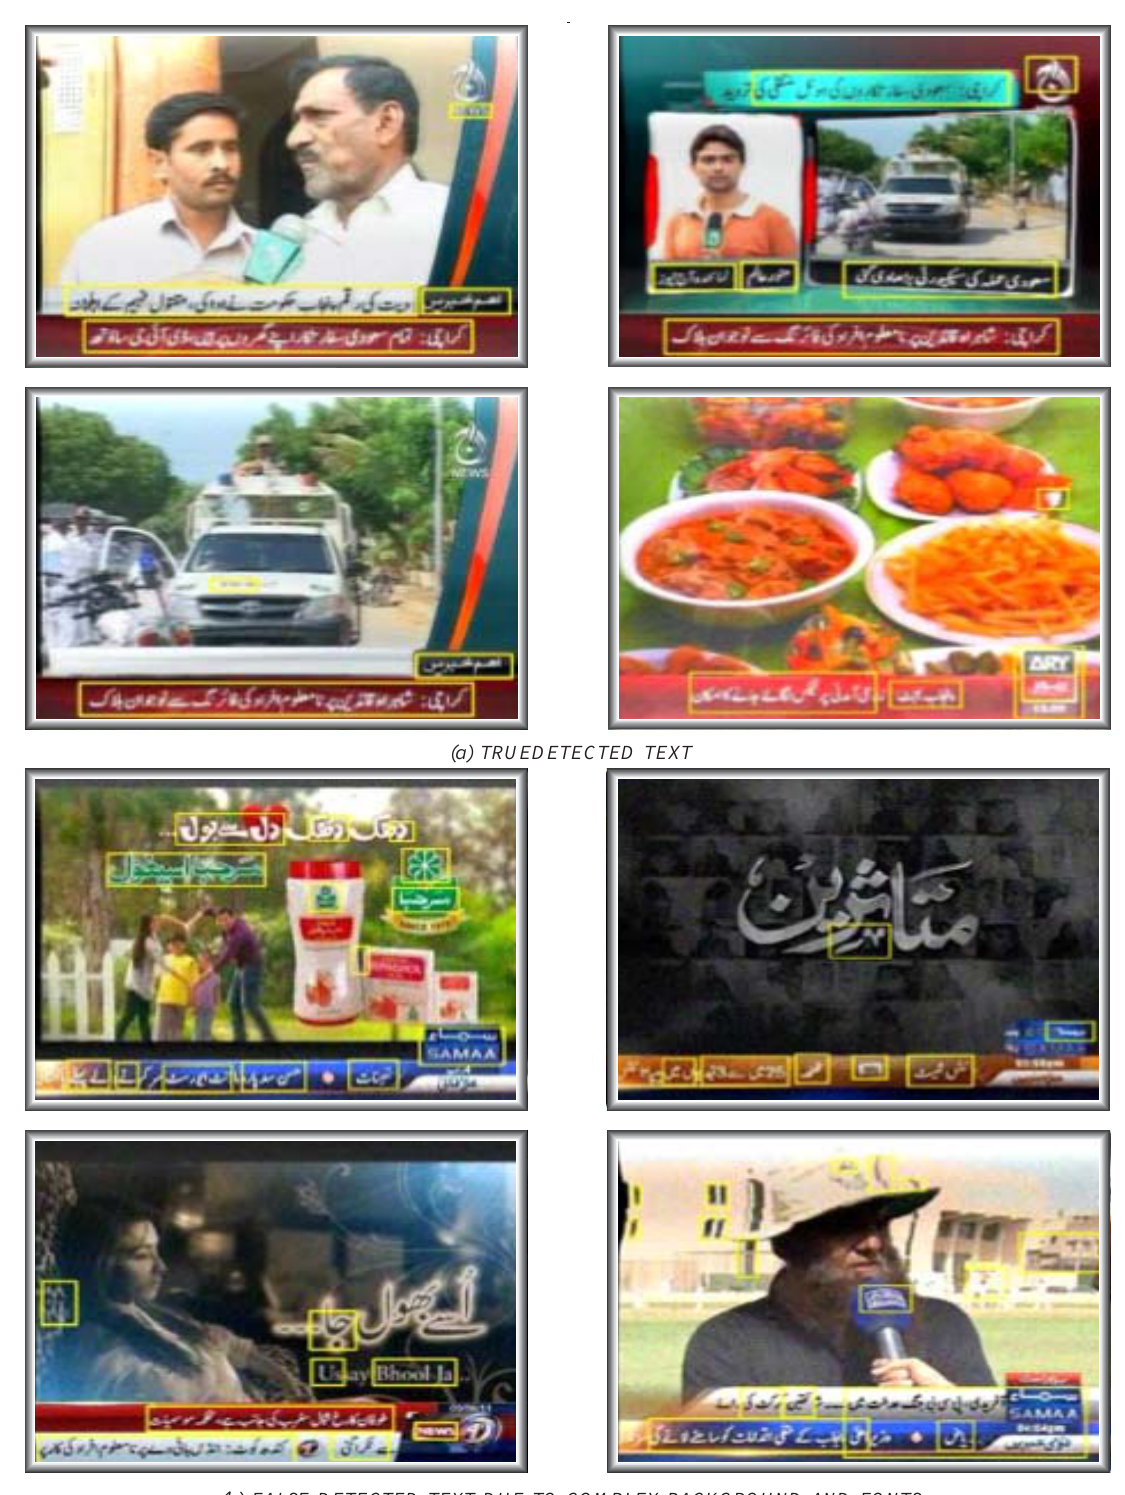
FIG. 6. TEXT DETECTION